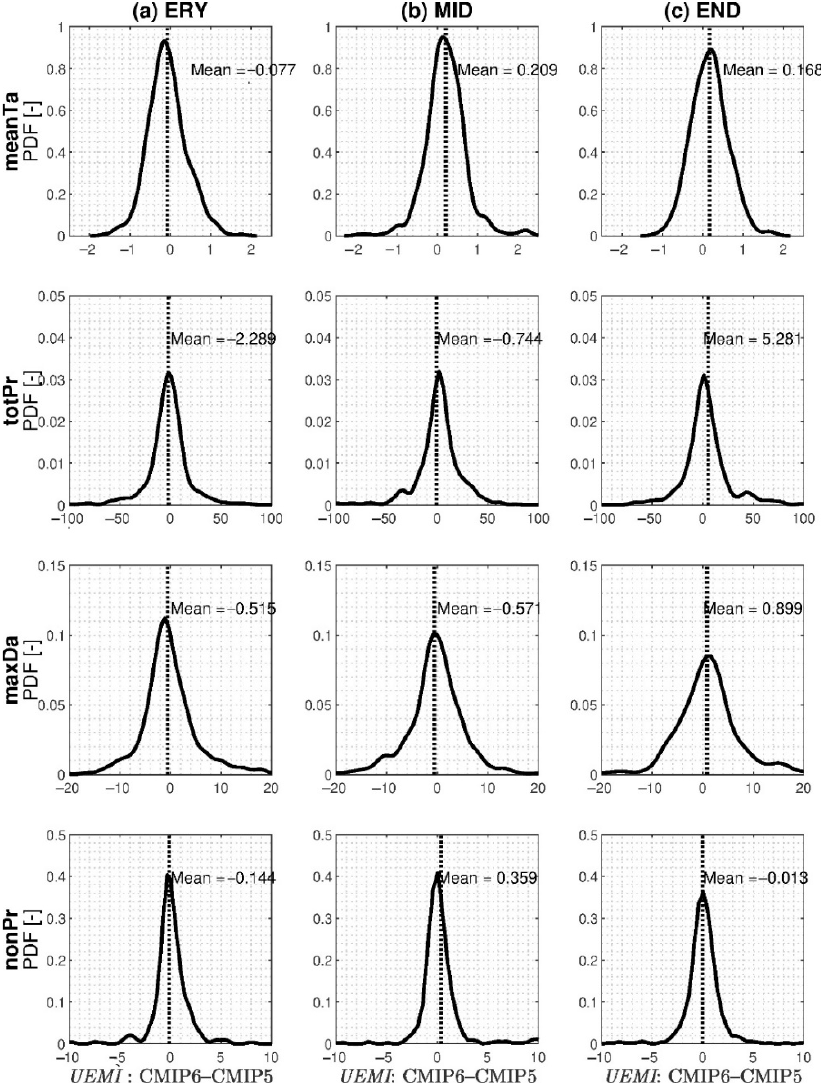
Figure 11. Comparisons of the UEMI values between CMIP5 and CMIP6 for 4 indices: meanTa, totPr, maxDa, and nonPr in the ( a ) ERY, ( b ) MID, and ( c ) END periods. The number of data points to make the distribution is 520 (40 locations × 13 (12 months + year)).